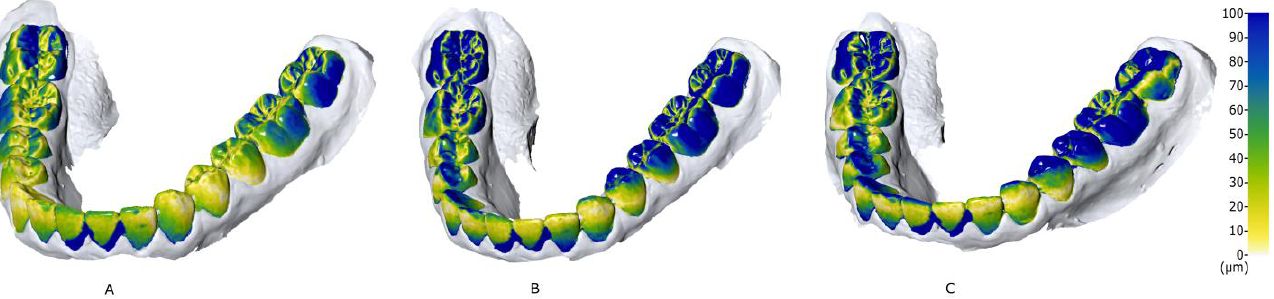
Figure 4. Representative superimpositions for each scanning strategy ( A – C ). The color-map indicates the trueness of Medit i500. Premolars and molars of the lower left quadrant presented inferior trueness, probably because this region was the scan’s starting point for all strategies. Values in μm. The mean precision values of the IOS were 2.7 (±2.4) μ m, 4.7 (±3.0) μ m, and 3.4 (±2.7) μ m for scanning strategies A, B, and C, respectively (Table 5). Table 5. Results of the precision study of the IOS. Mean of the standard deviations (±standard deviation) for each scanning strategy and examiner.